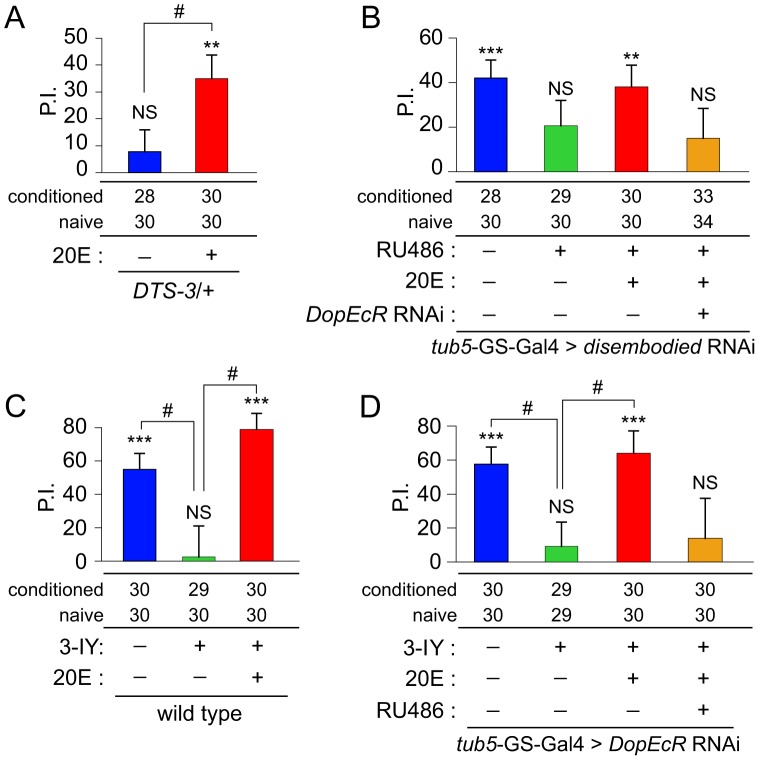
Impaired ecdysone synthesis causes a courtship memory defect.(A) Rescue of courtship memory in DTS-3 males by feeding flies 20E prior to conditioning. (B) A defect in 30-minute courtship memory when the dib RNAi was expressed ubiquitously in adults, in response to RU486 application (tub5-GS-Gal4 driver). The dib RNAi-induced memory defect was not observed when flies were fed 20E, but was observed when 20E feeding was accompanied by the expression of the DopEcR RNAi. (C) Rescue of courtship memory in 3-iodo tyrosine (3-IY)-treated males by feeding flies 20E prior to conditioning. (D) Courtship memory in 3-IY-treated males was not restored by 20E when the DopEcR RNAi was expressed ubiquitously in adults. For 20E and RU486 feeding experiments, control flies received vehicle. The presence or absence of courtship memory was evaluated by applying the Mann–Whitney U-test to naïve and conditioned flies. Statistical significance is shown above each bar. NS, no significant difference. **, P<0.01; ***, P<0.001. Sample numbers for naïve and conditioned flies are shown under each graph. PIs were analyzed using Student's t-test or Krustal-Wallis One-Way ANOVA. #, P<0.05. Error bars (s.e.m.).